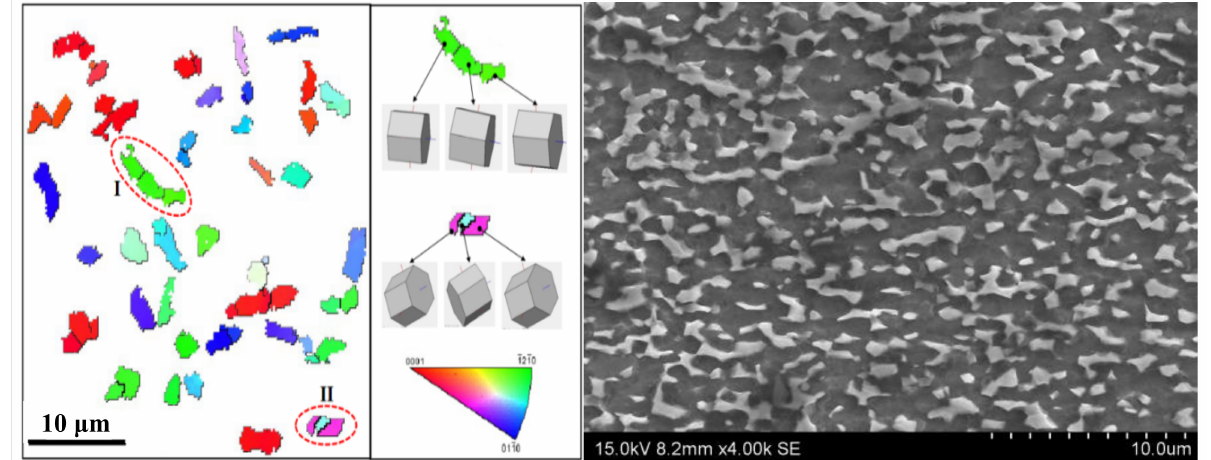
Figure 9. The inverse pole figure (IPF) of alpha phase for SP700Cr alloy after AC820 + AC500.